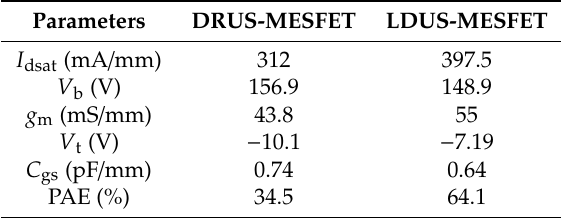
Table 2. Comparison of performance parameters of the two